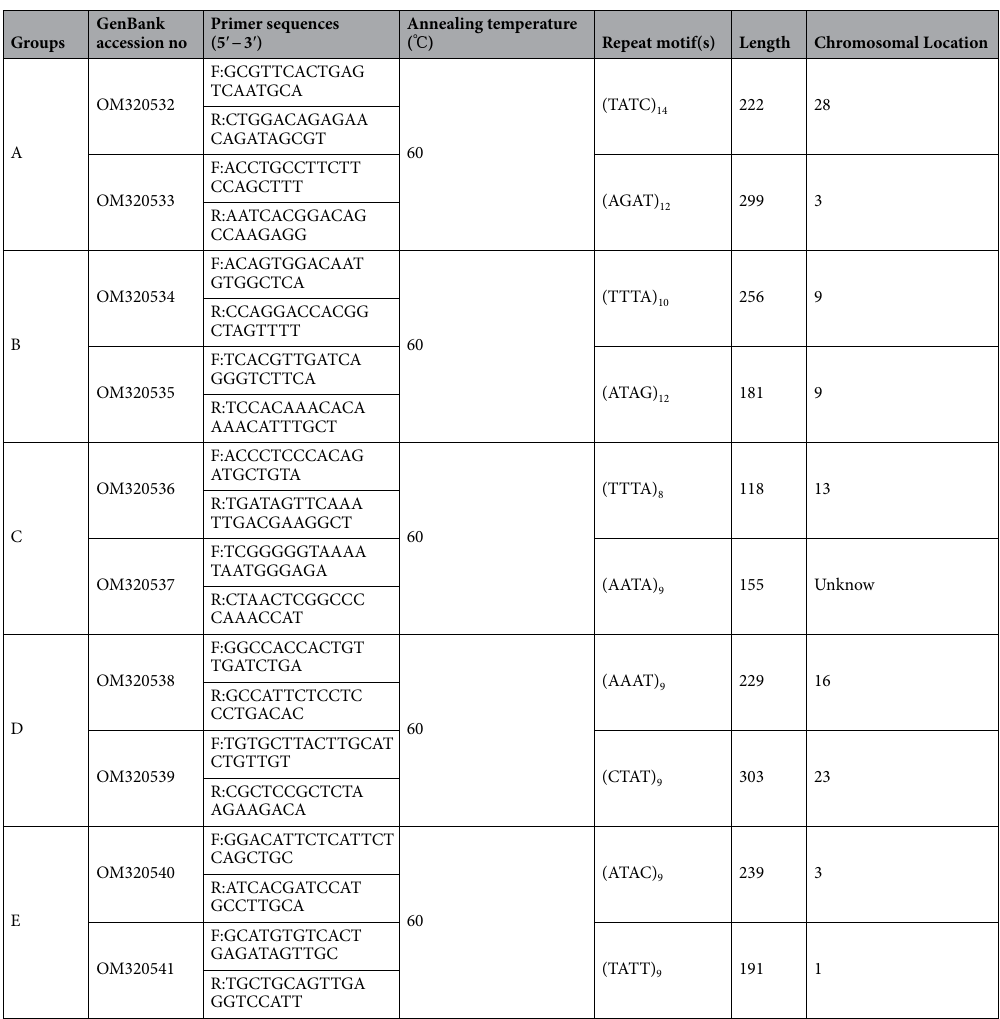
Table 1. Characterization of five duplex PCR reactions in